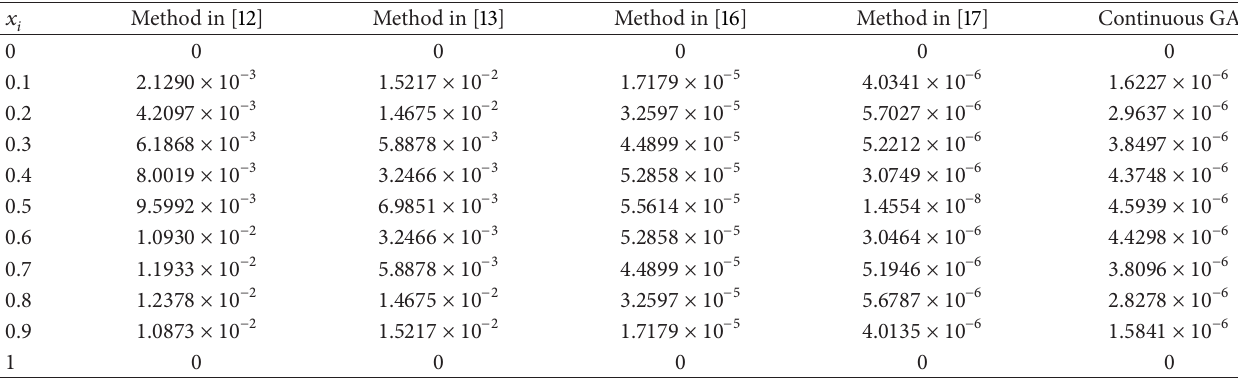
Table 8: Absolute error results for Bratu’s problem with 𝜇 = 2